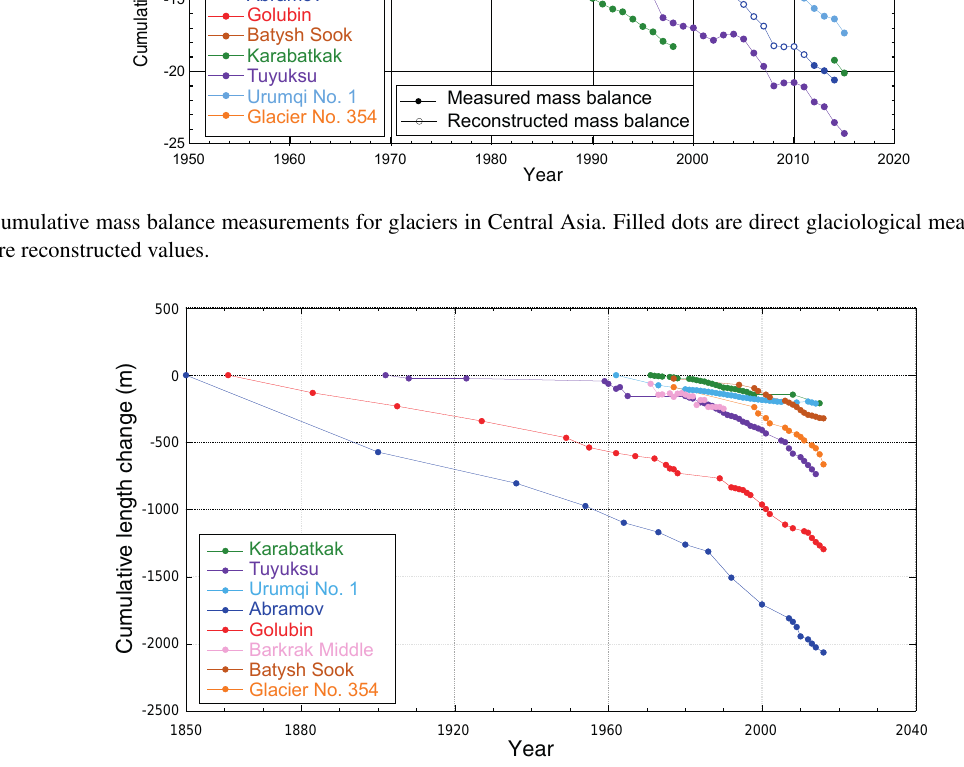
Figure 7. Cumulative front variation measurements for glaciers in Central